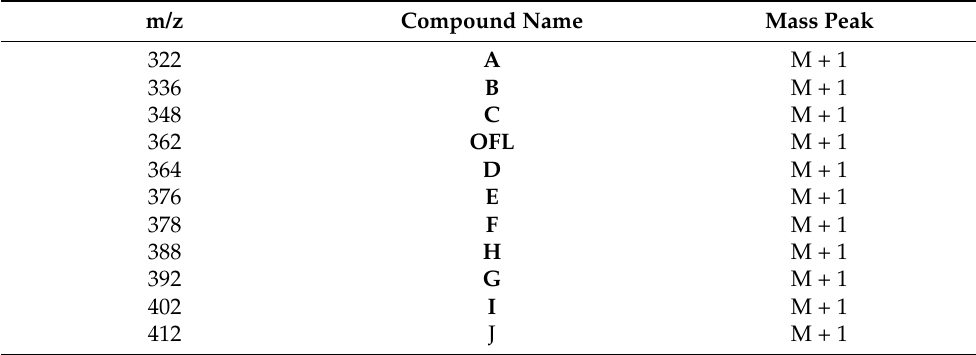
Figure 4. Three-dimensional view of the OFL decomposition by BT catalyst with the irradiation time of 60 min (purple) and 90 min (yellow). Table 2. M + 1 peak of photoproducts from lower to higher m/z values.